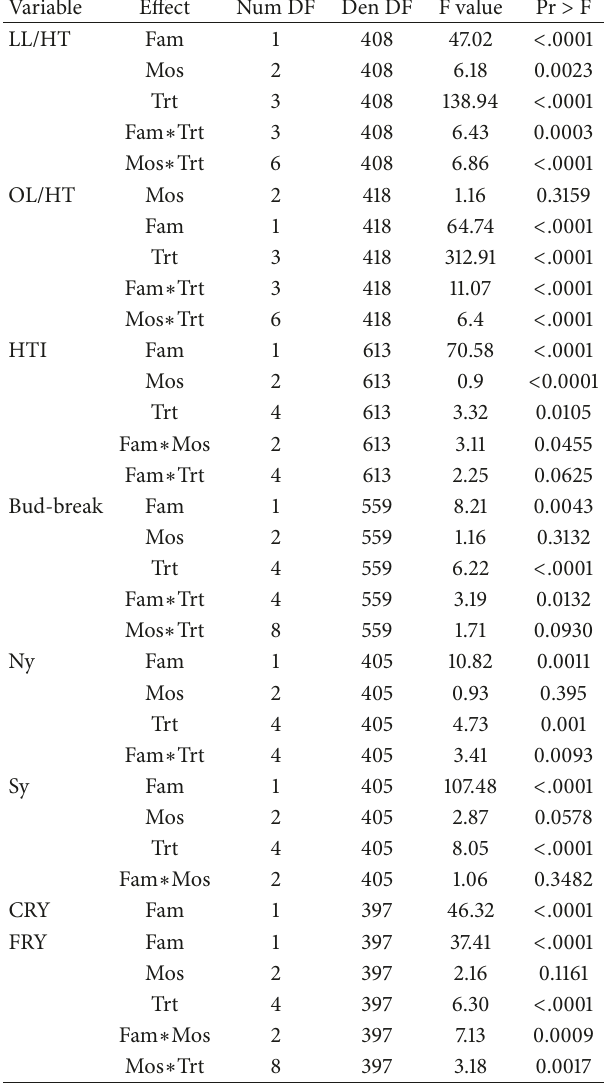
Table 2: Type three fixed effects of lesion and occlusion length by seedling height ratio, height increase, new bud-break, and dry biomass of various plant parts.